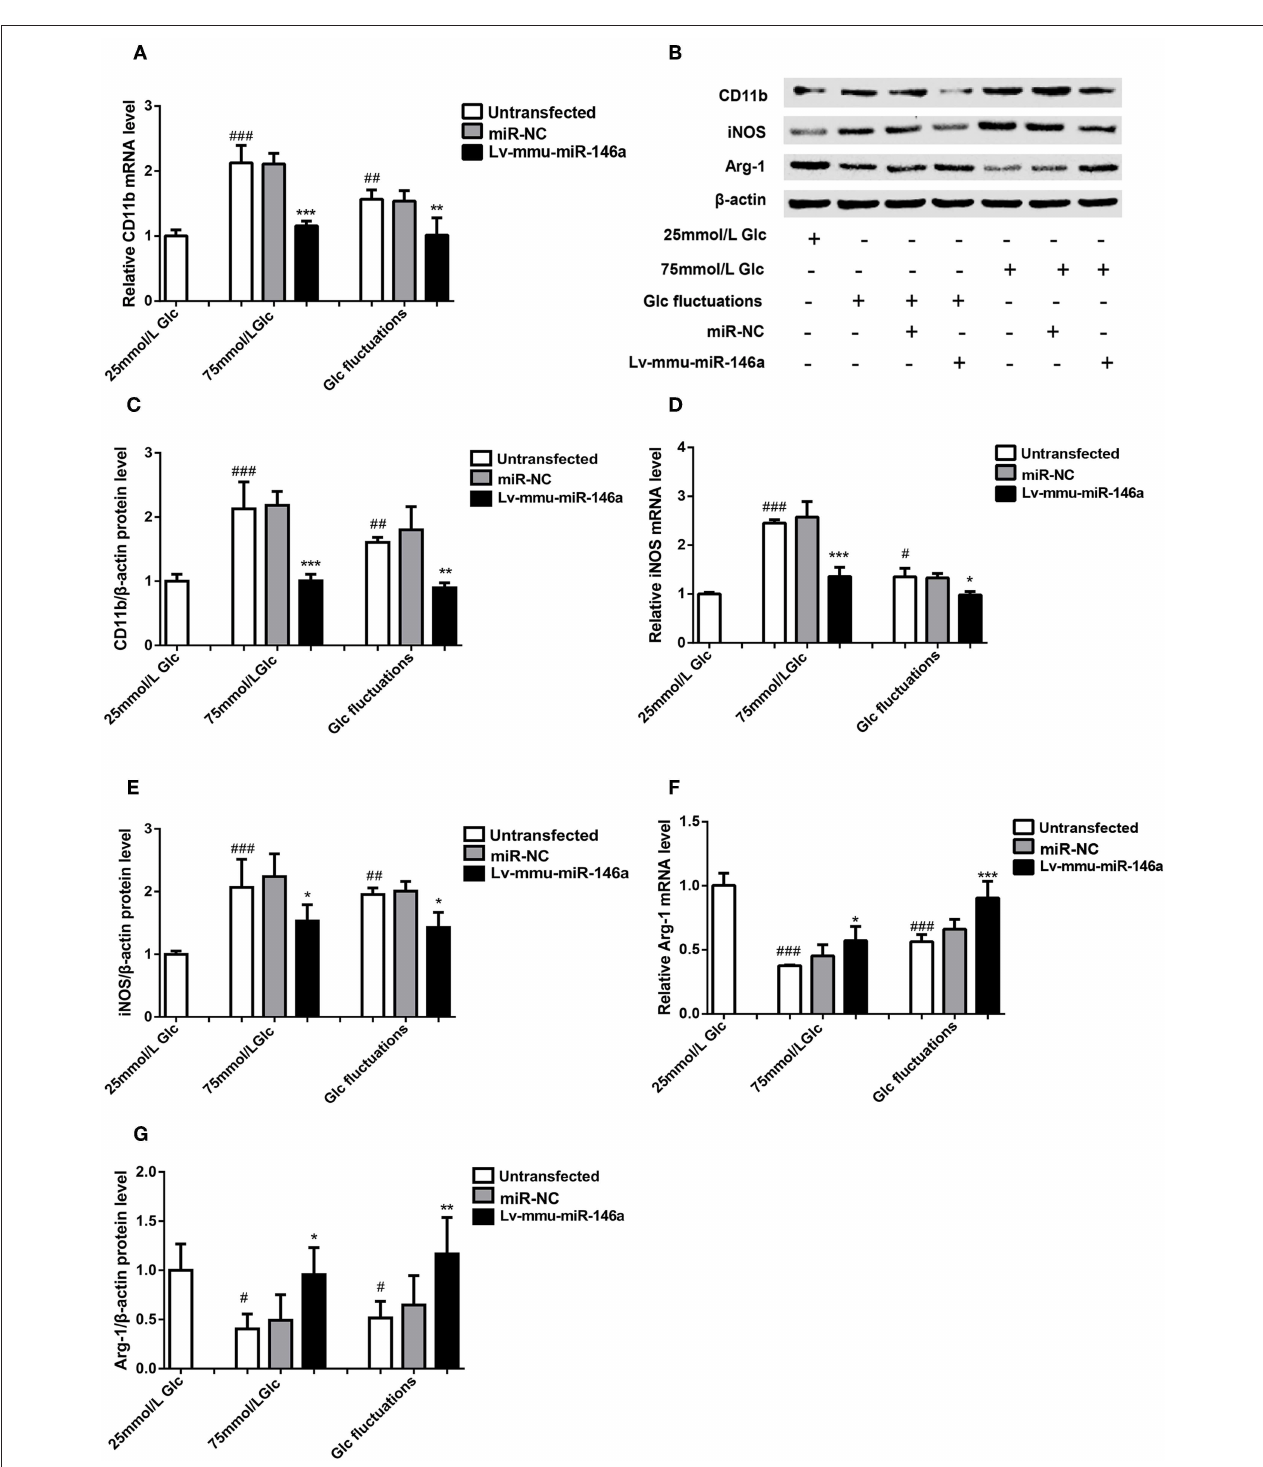
FIGURE 4 | Effects of miR-146a on polarization transitions in BV-2 cells induced by high glucose and glucose fluctuation. (A) CD11b mRNA expression levels. *** p < 0.001, 75 mmol/L Glc + Lv-mmu-miR-146a group vs. 75 mmol/L Glc group; ** p < 0.01, Glc fluctuation + Lv-mmu-miR-146a group vs. Glc fluctuation group; ### p < 0.001, 75 mmol/L Glc vs. control; ## p < 0.01, Glc fluctuation group vs. control. (B) Western blot for CD11b, iNOS, and Arg-1 protein detection. (C) Expression levels of CD11b protein. *** p < 0.001, 75 mmol/L Glc + Lv-mmu-miR-146a group vs. 75 mmol/L Glc group; ** p < 0.01, Glc fluctuation + Lv-mmu-miR-146a group